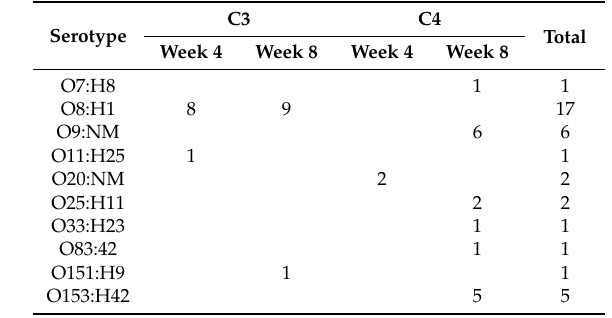
Table 1. Serotyping of the 37 E. coli CFR isolates from manures of farm C3 and farm C4 incubated at 4 °C first.